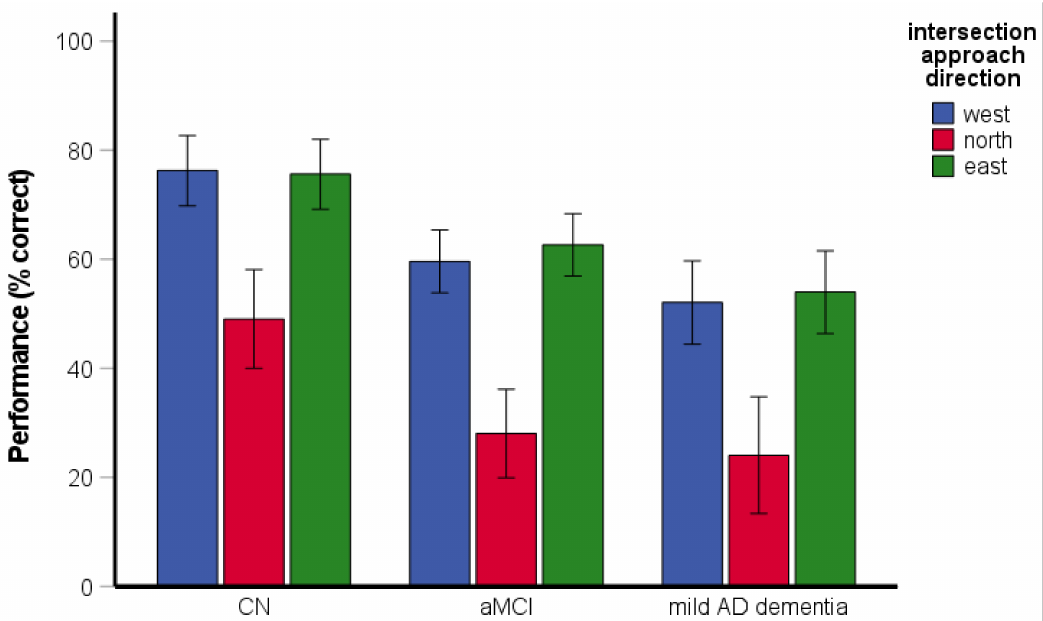
Figure 8. Directional-approach task—spatial navigation performance and the effect of approach direction. CN, cognitively normal; aMCI, amnestic mild cognitive impairment; mild AD dementia, mild Alzheimer’s disease